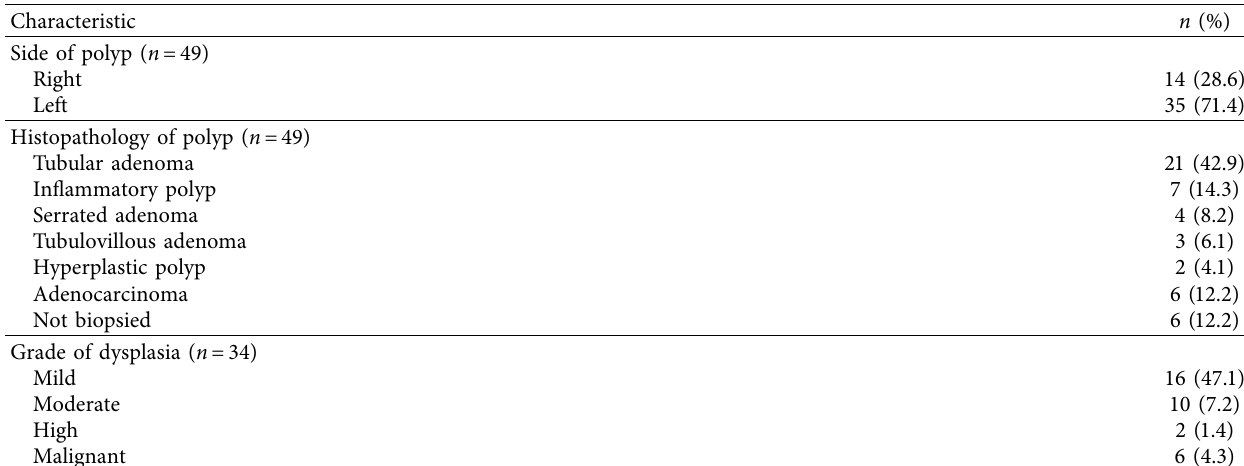
Table 2: Characteristics of the polyps ( n � 49).